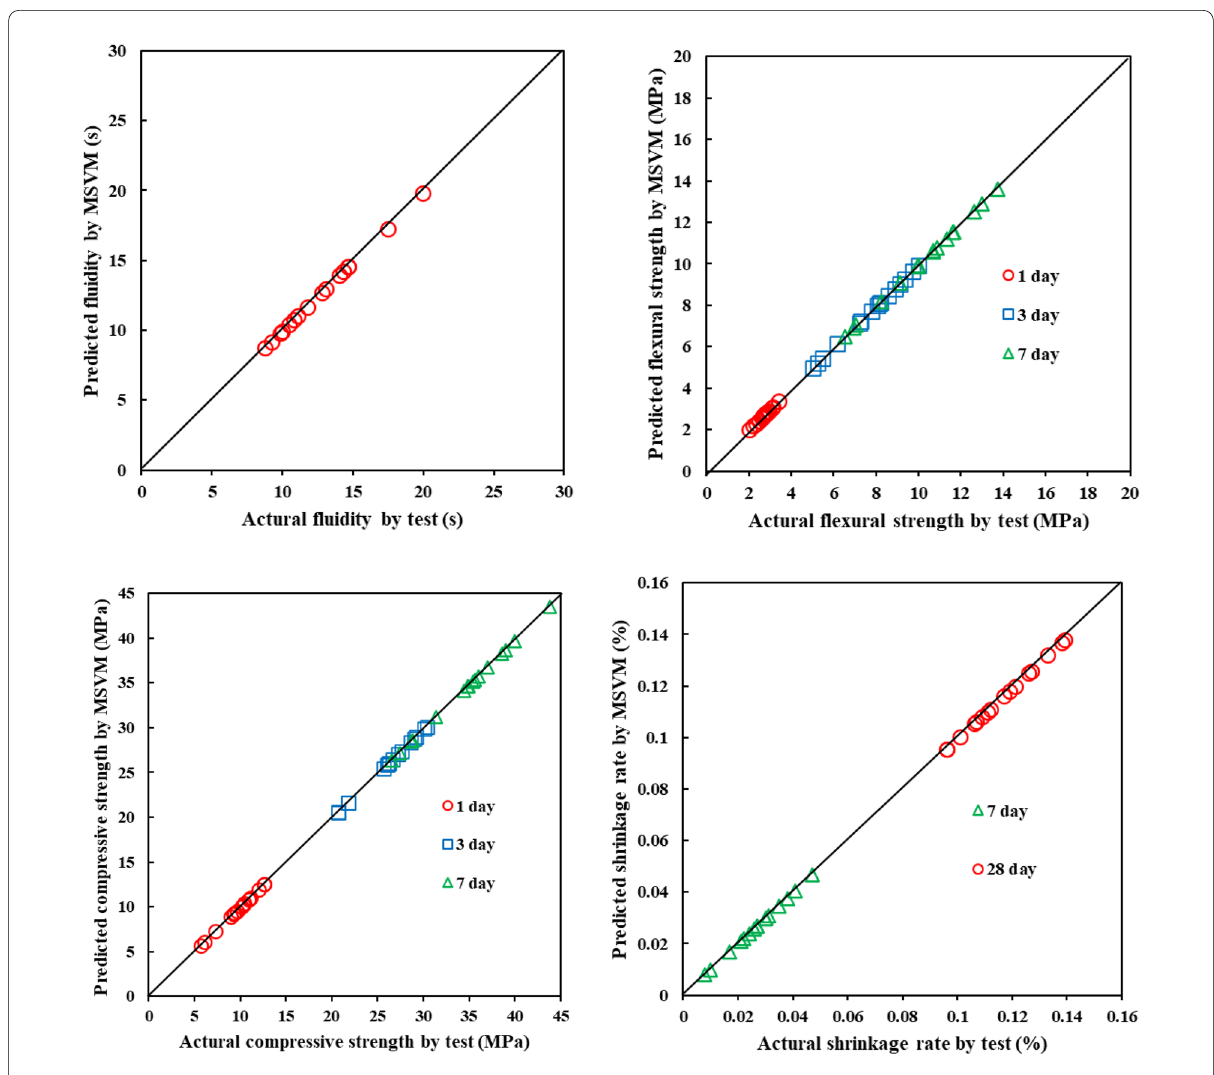
Fig. 6 Predicted performance of the proposed